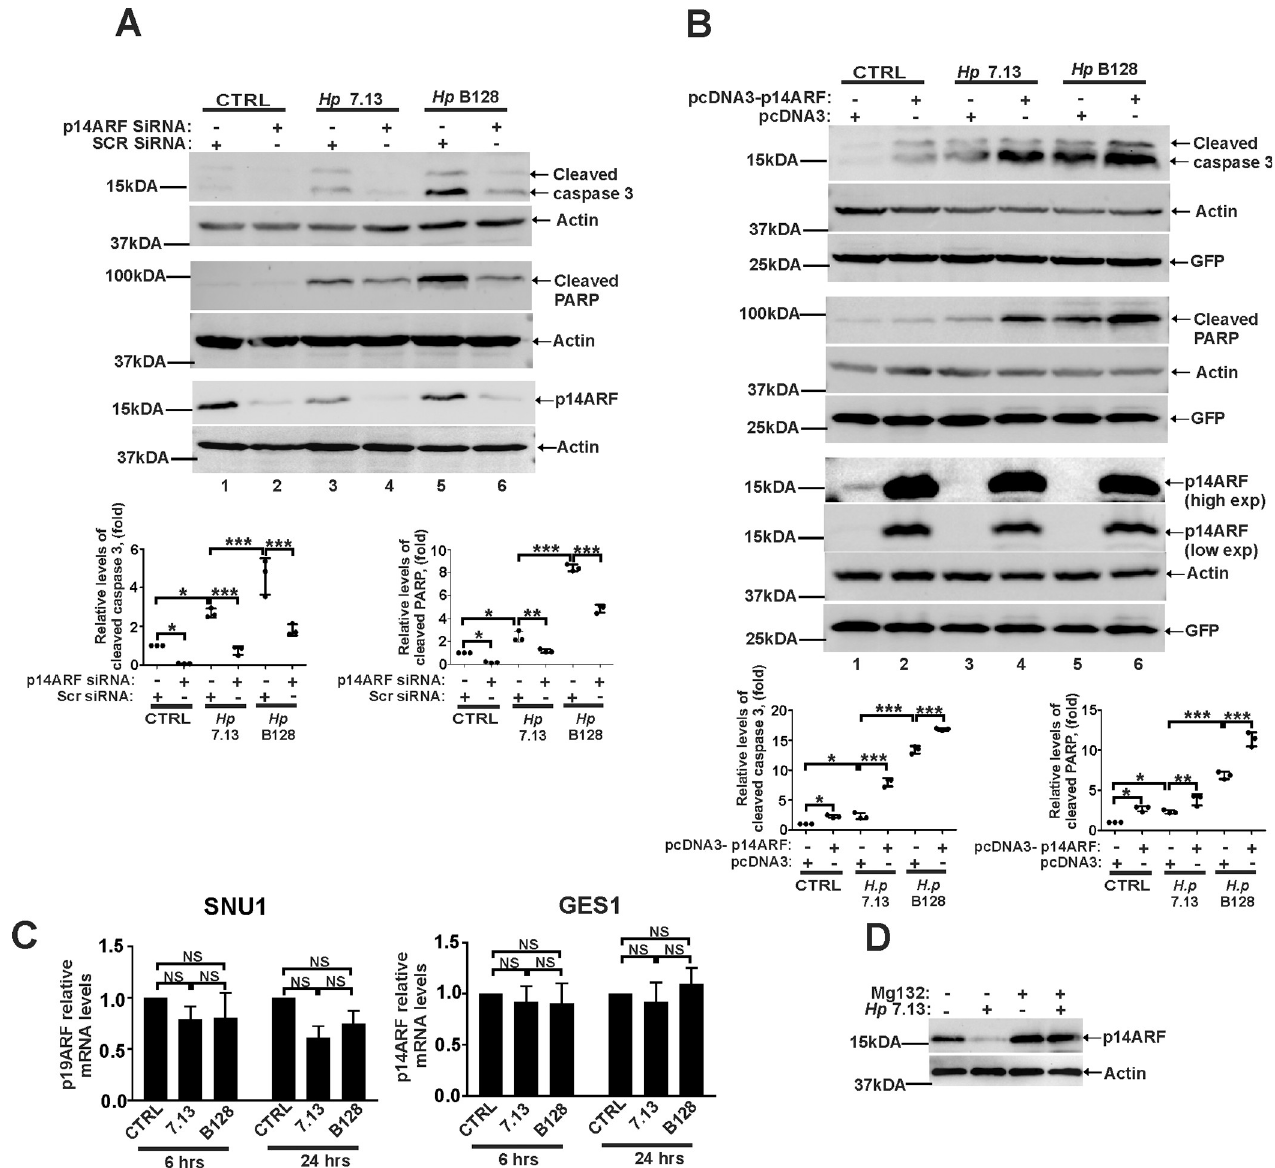
Fig 2. ARF regulates apoptosis in H . pylori infected cells. (A) Western blot analysis of apoptosis markers, cleaved caspase 3 and PARP in SNU1 cells transfected with p14ARF siRNA or control scrambled siRNA (Scr siRNA) and then either co-cultured with H . pylori strains 7.13 or B128 for 18 hours or left uninfected. Each experiment was carried out three times (n = 3), with representative blots displayed. Bottom panels show the densitometric analyses. Protein expression levels in control cells were arbitrarily set at 1. (B) The same as (A), but AGS cells were transfected with pcDNA3-p14ARF expression plasmid or empty pcDNA3 vector. (C) qPCR analysis of p14ARF mRNA in SNU1 and GES1 cells co-cultured with H . pylori strains 7.13 or B128 for the indicated time periods. Expression of p14ARF mRNA in uninfected cells was arbitrarily set at 1. (D) SNU1 cells co-cultured with H . pylori strain 7.13 were treated